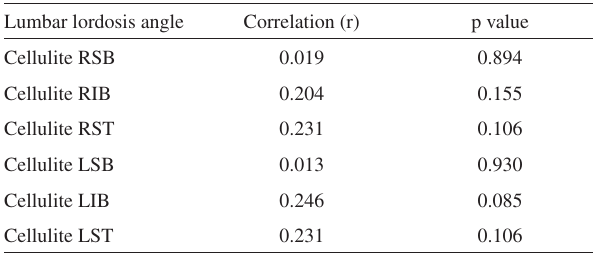
Table 4 - Spearman’s correlation (r) and p value for the degree of cellulite and the lumbar lordosis angle